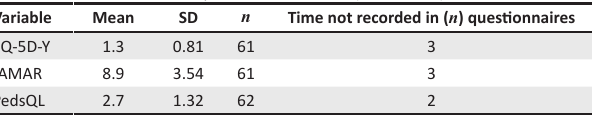
TABLE 4: Time taken to complete the measures (in minutes). n = 64. Variable Mean SD n